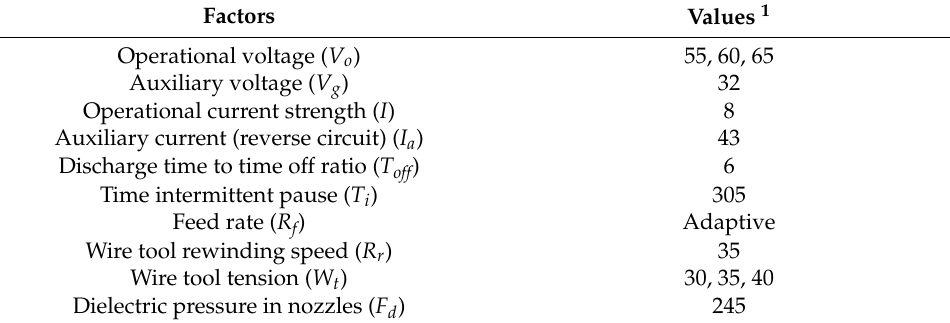
Table 2. Electrical discharge machining factors (Seibu M500S machine).